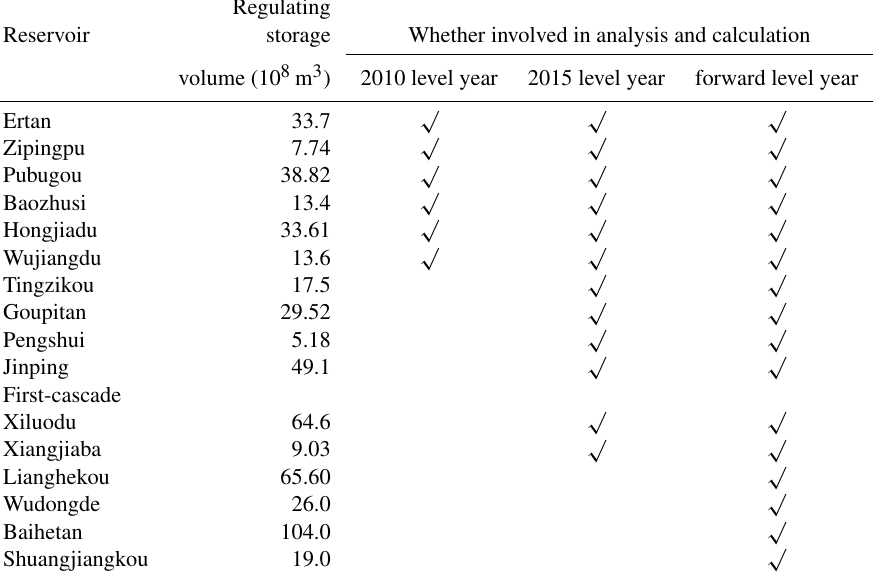
Table 1. Reservoirs analyzed and calculated in different level years. Regulating Reservoir